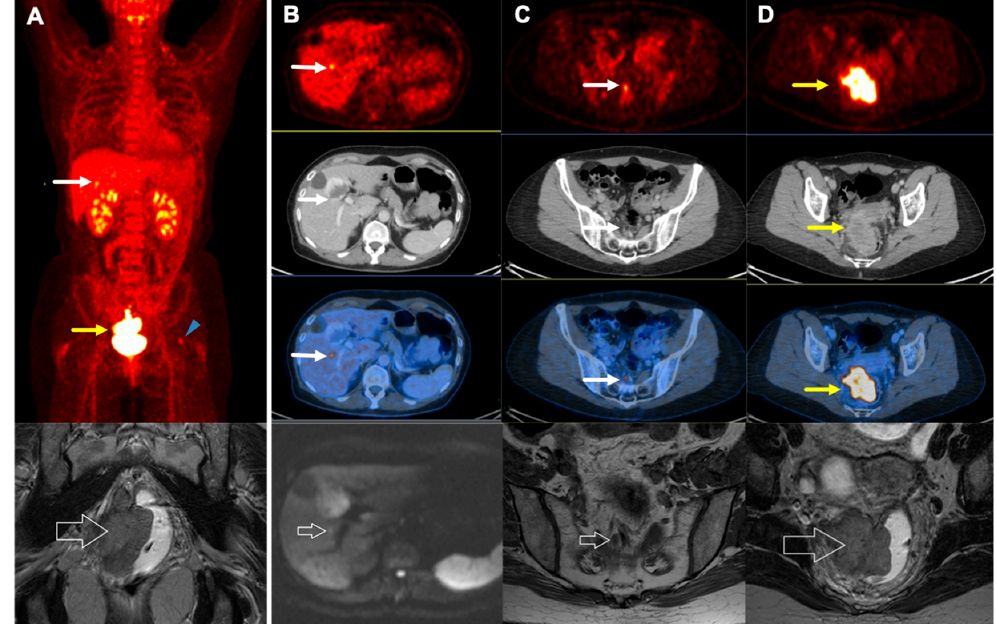
Figure 5. A 55-year-old female with Grade III, T4N1aM1 disease. ( A ) (upper): MIP (maximum intensity projection): Aside from the primary tumor, there is a small additional focus in the right liver lobe indicative of metastasis (white arrow). Also, mild 2-[ 18 F]FDG uptake is seen in the left femoral head which represents an enchondroma (blue arrowhead). ( A ) (lower): MRI (magnetic resonance imaging), coronal T2 Turbo Spin Echo Sequence shows primary anal cancer and corresponding morphological changes (arrow). ( B ): Transverse PET (upper 1st row), CT (2nd row), and Fused (3rd row) images: The tiny metastatic lesion is seen in the right liver lobe (white arrow). ( B ) (4th row): Liver MRI (Axial DWI 800 Sequence) shows only discreet diffusion restriction on the axial DWI 800 sequence with little correlation on the ADC map (arrow). ( C ): Transverse PET (upper 1st row), CT (2nd row), and Fused (3rd row) images: A metastatic mesorectal lymph node (white arrow). ( C ) (4th row): MRI, axial T1 TSE sequence highlighting the metastatic mesorectal lymph node (arrow) ( D ): Transverse PET (upper 1st row), CT (2nd row), and Fused (3rd row) images: The primary tumor with evidence of extension to the posterior wall of the cervix and vagina. ( D ) (4th row): coronal T2 Turbo Spin Echo Sequence shows primary anal cancer and corresponding morphological changes (arrow).